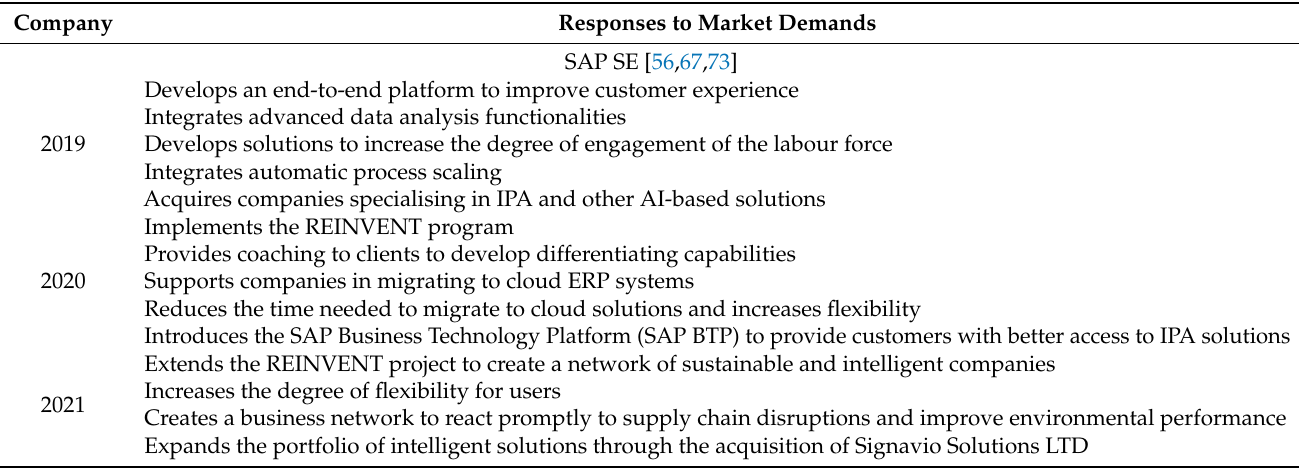
Table 3. The developer responses to market demands to improve